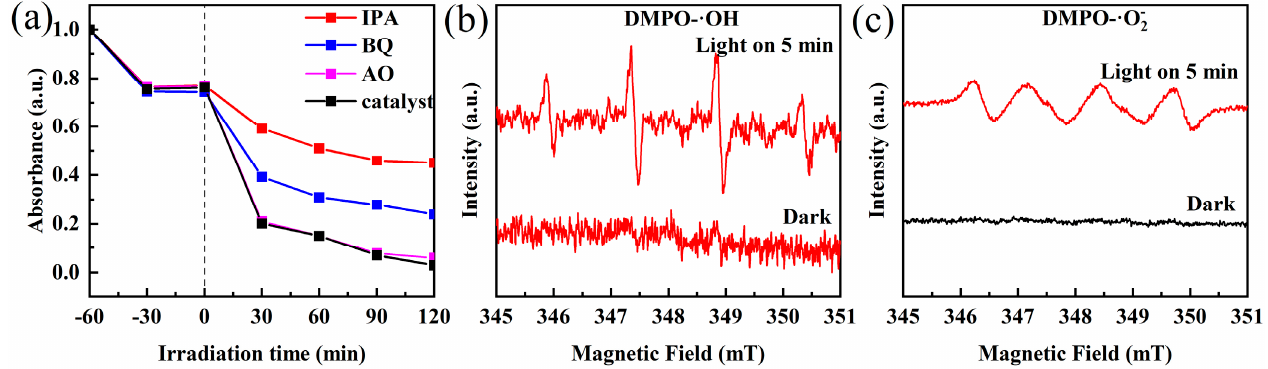
Figure 10. Experiments of radical trapping ( a ) ESR detection for 10% BiPO 4 /Ov-BiOBr under dark and visible light irradiation: DMPO- · OH ( b ) and DMPO- · O 2 − ( c ).